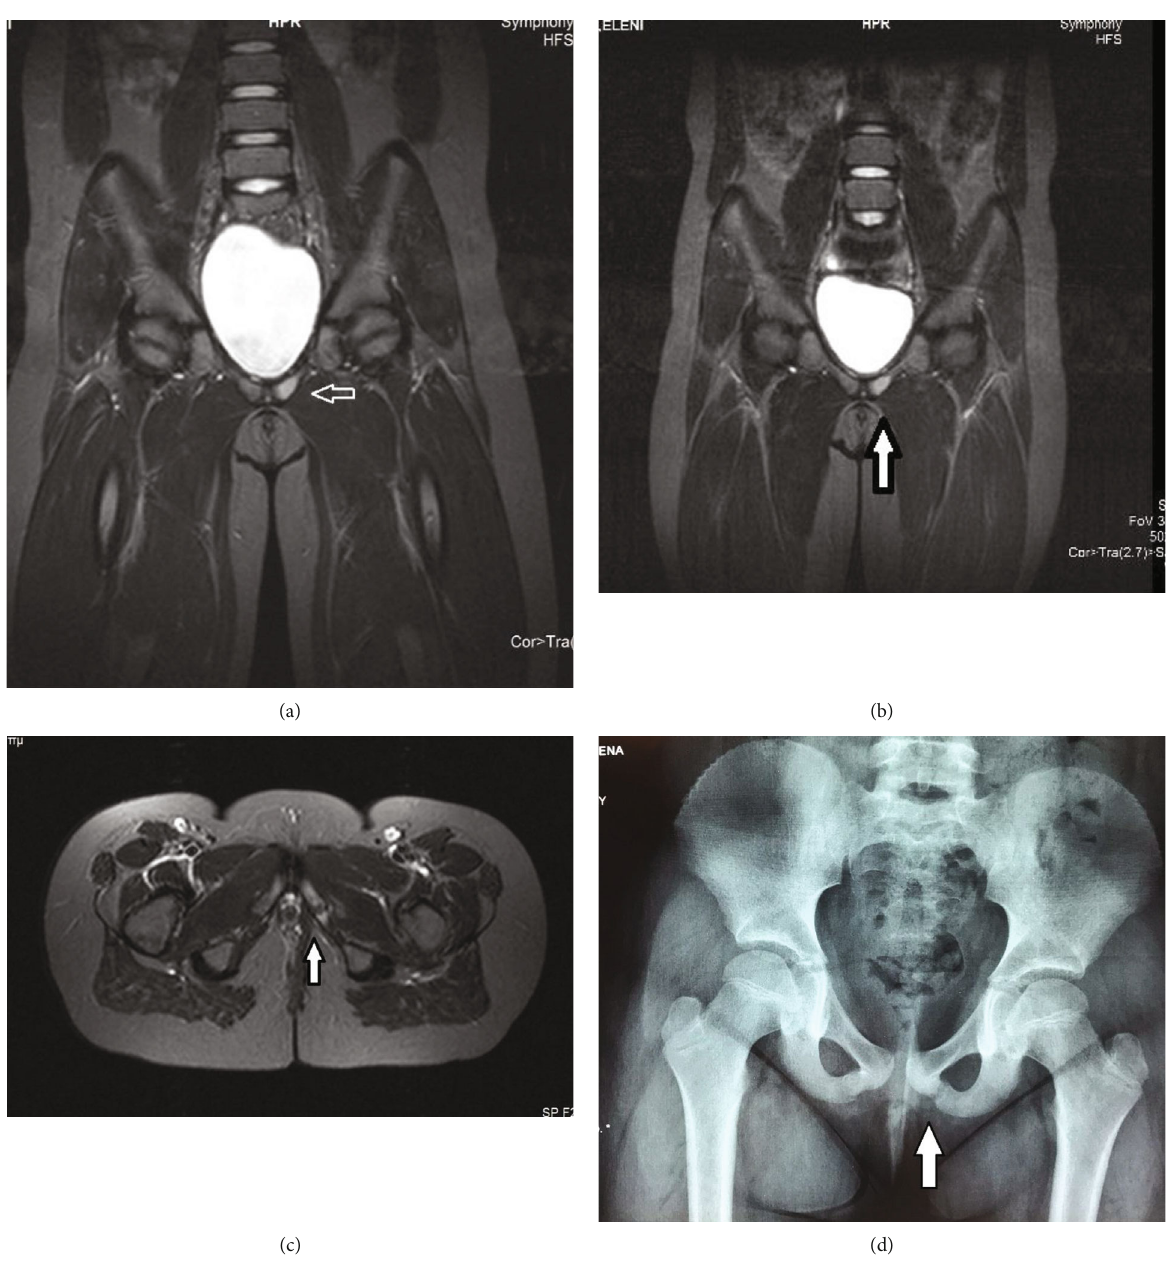
Figure 4: (a – c) STIR sequences in (a and b) coronal and (c) transverse plane demonstrate bone marrow edema of the left ischium, with normal appearance of the cortex and normal appearance of the adjacent muscles. (d) Asymmetric enlargement and diastasis of the left ischiopubic